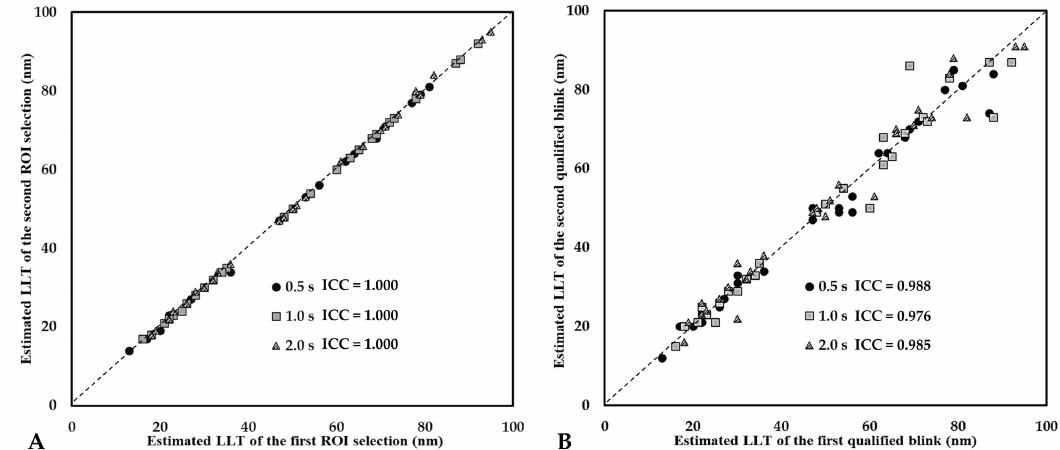
Figure 7. Non-segmentation images were used to assess the reliability of estimated lipid layer thickness for each subject at the representative time points, 0.5 s, 1.0 s, and 2.0 s ( N = 28). ( A ) the reliability of estimated LLTs in two repeated ROI selections for the first qualified blink cycle; ( B ) the reliability of estimated LLTs of the first and second qualified blink cycle. ICC = intraclass correlation coe ffi